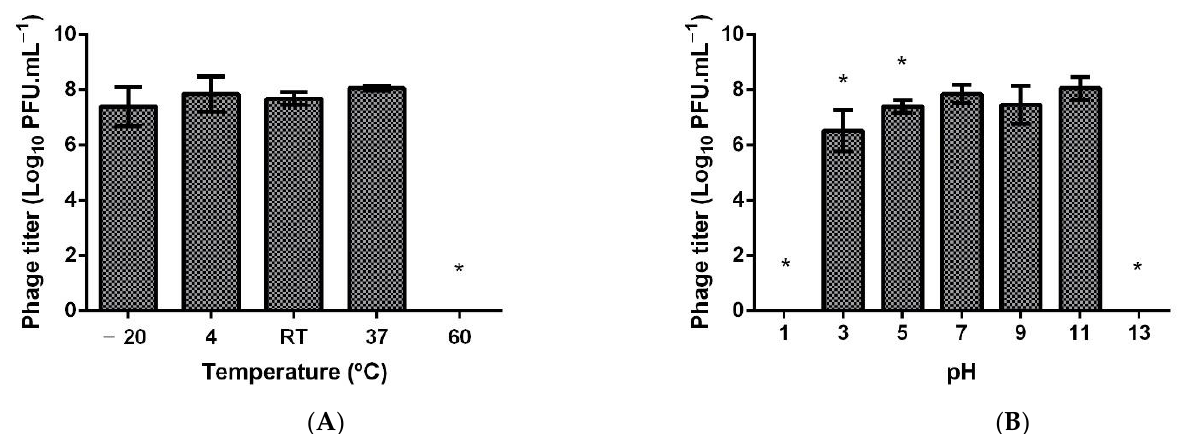
Figure 3. Thermal and pH stability of the HPy1R phage. ( A ) Thermal assays were performed under different temperatures ( − 20 °C, 4 °C (control), room temperature (25 °C), 37 °C, and 60 °C) for 24 h. ( B ) pH assays were performed under different pH levels (1, 2, 3, 5, 7 (control), 9, 11, 13), for 24 h at room temperature. Error bars represent standard deviations for three independent assays ( n = 3) performed in duplicate. * Statistical differences compared with the control ( p < 0.05).